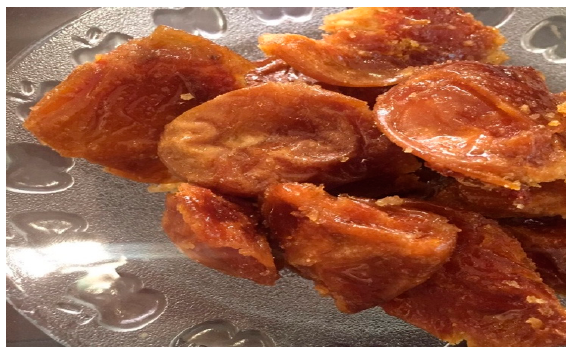
Figure 23. Sample of Al-Skari Macnooz dates.